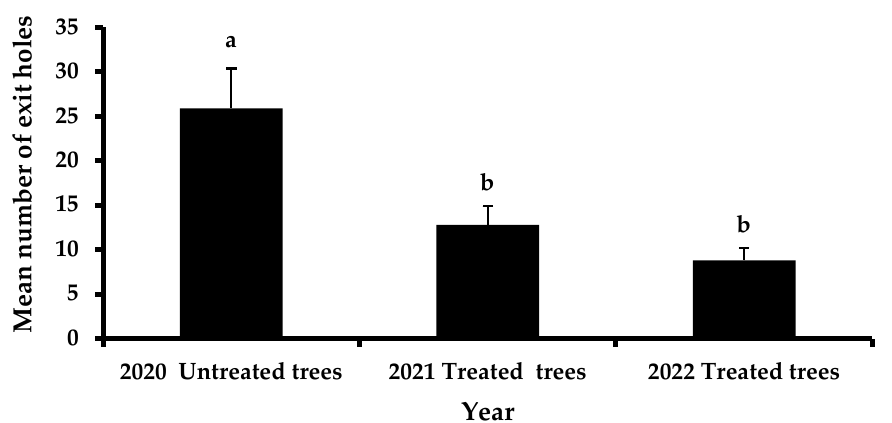
Figure 2. Mean number (+ Standard Error) of Xylotrechus chinensis exit holes from the tested trees before the trunk injection method is applied, in 2020, and after the application of trunk injection method, in 2021 and 2022. Different letters above columns indicate significant differences ( F = 8.0, DF = 2, 119, p = 0.01).